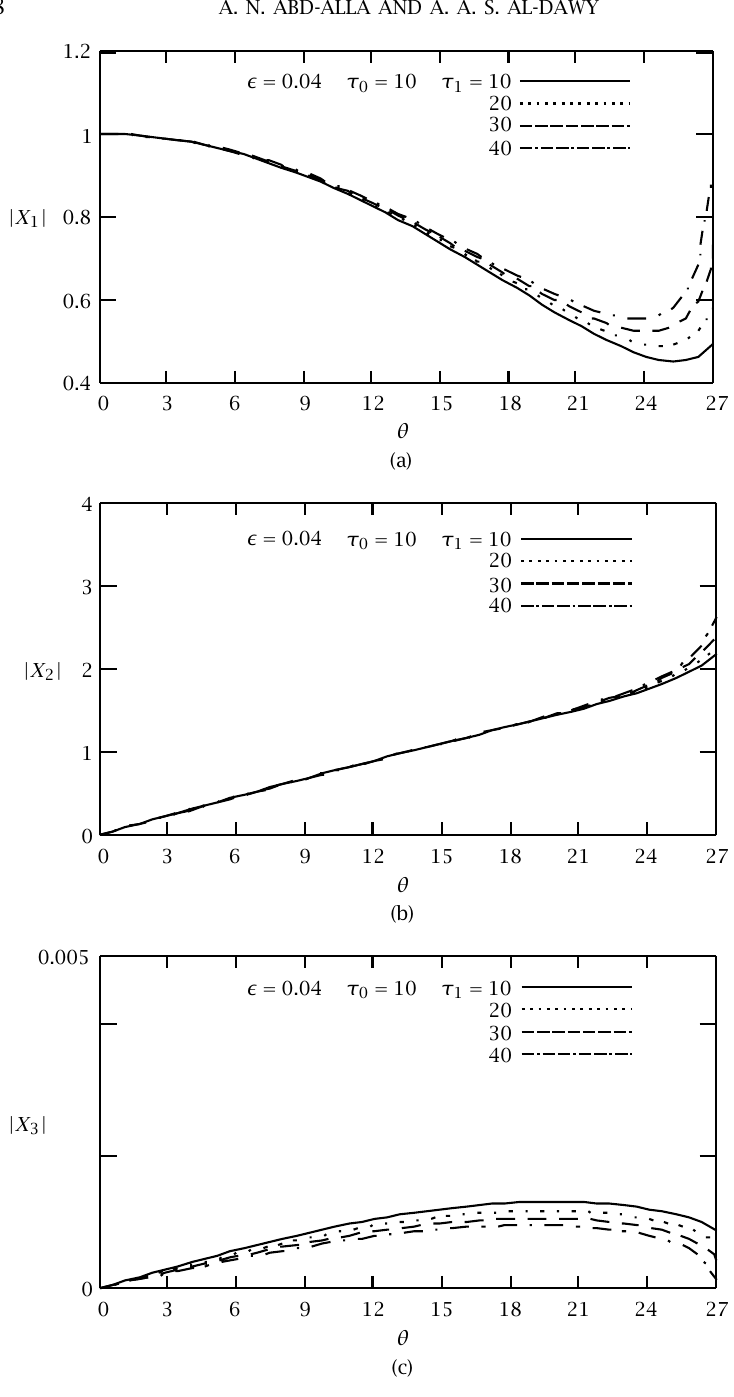
Figure 4 . (The effect of the thermal relaxation times in G-L theory) | X 1 | , | X 2 | , | X 3 | versus the angle of incidence θ